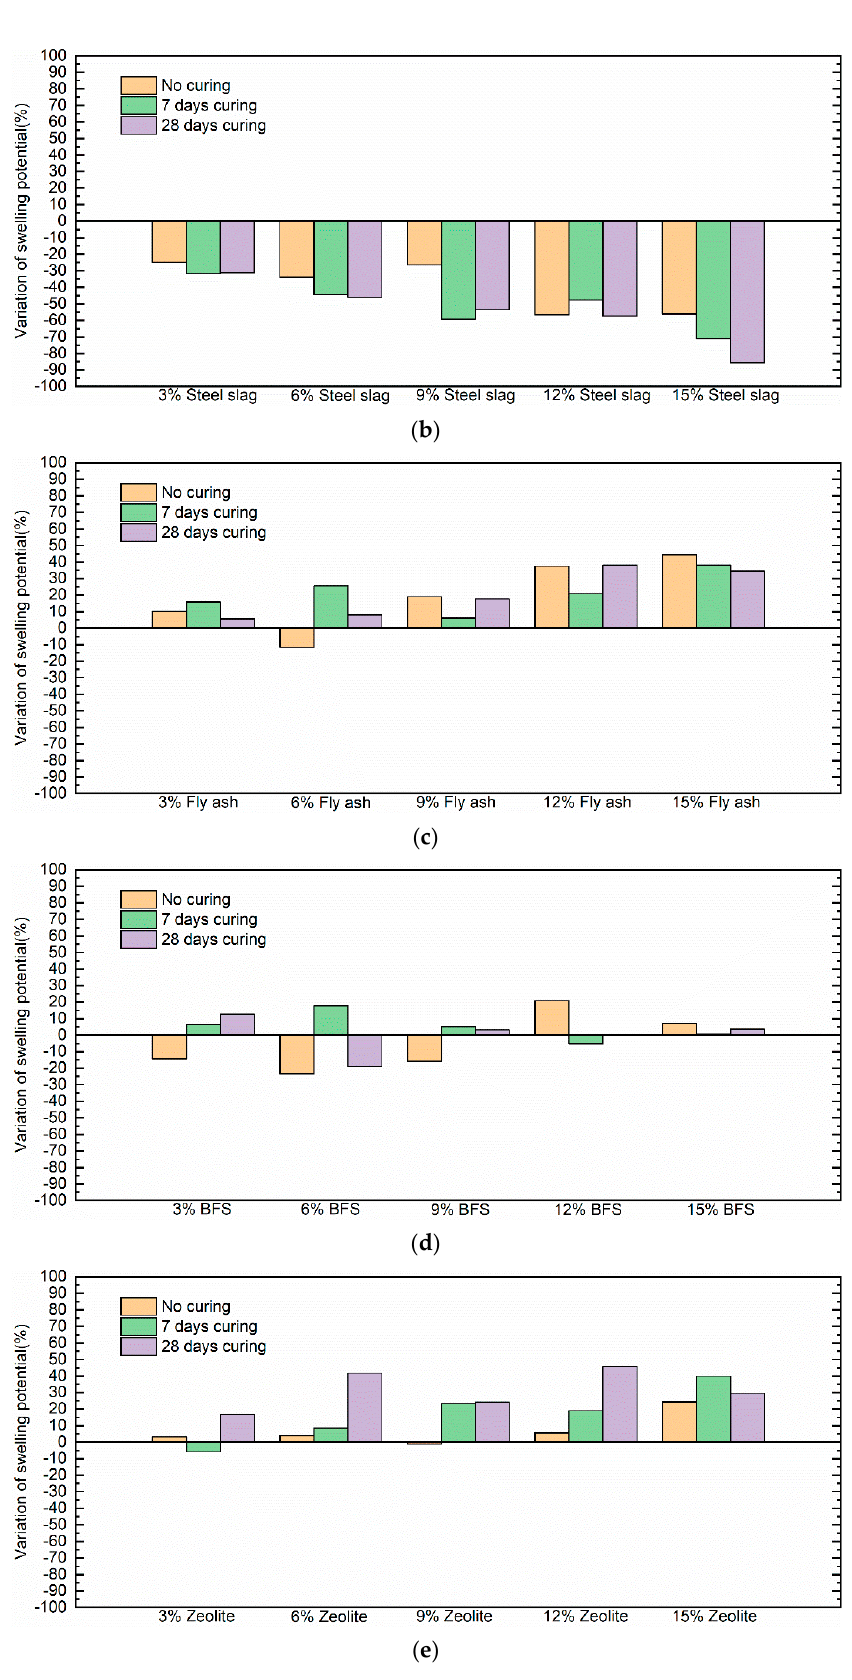
Figure 2. The change in the no loading swelling ratio of specimens with different additives relative to the red clay specimen: ( a )-cement, ( b )-steel slag, ( c )-blast furnace slag, ( d )-fly ash, ( e